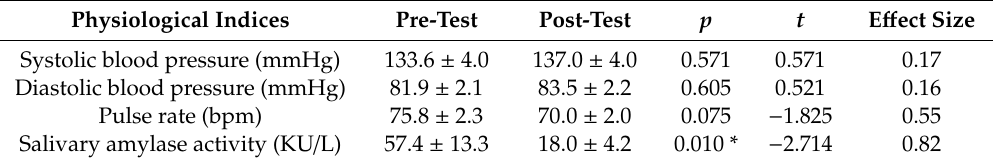
Table 5. E ff ect of Herb Tasting and Smelling on physiological